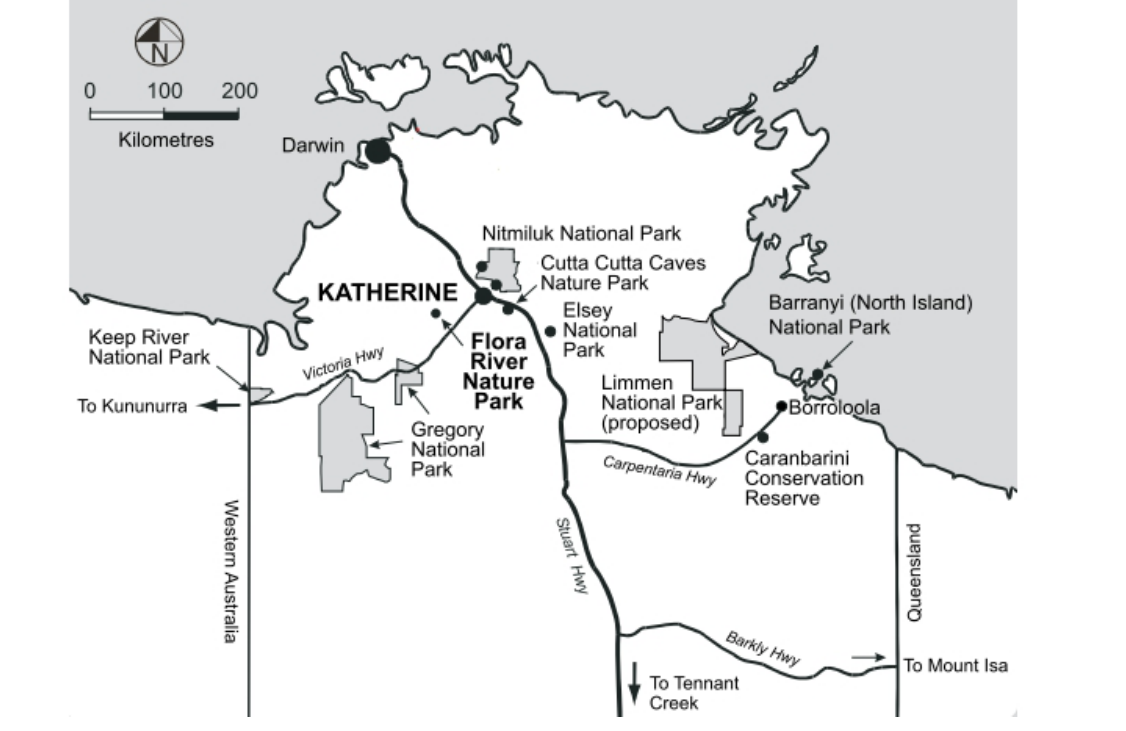
Fig. 1 . Location of Flora River Nature Park (source: Natural Resources, Environment, The Arts and Sports, Parks and Wildlife Commission